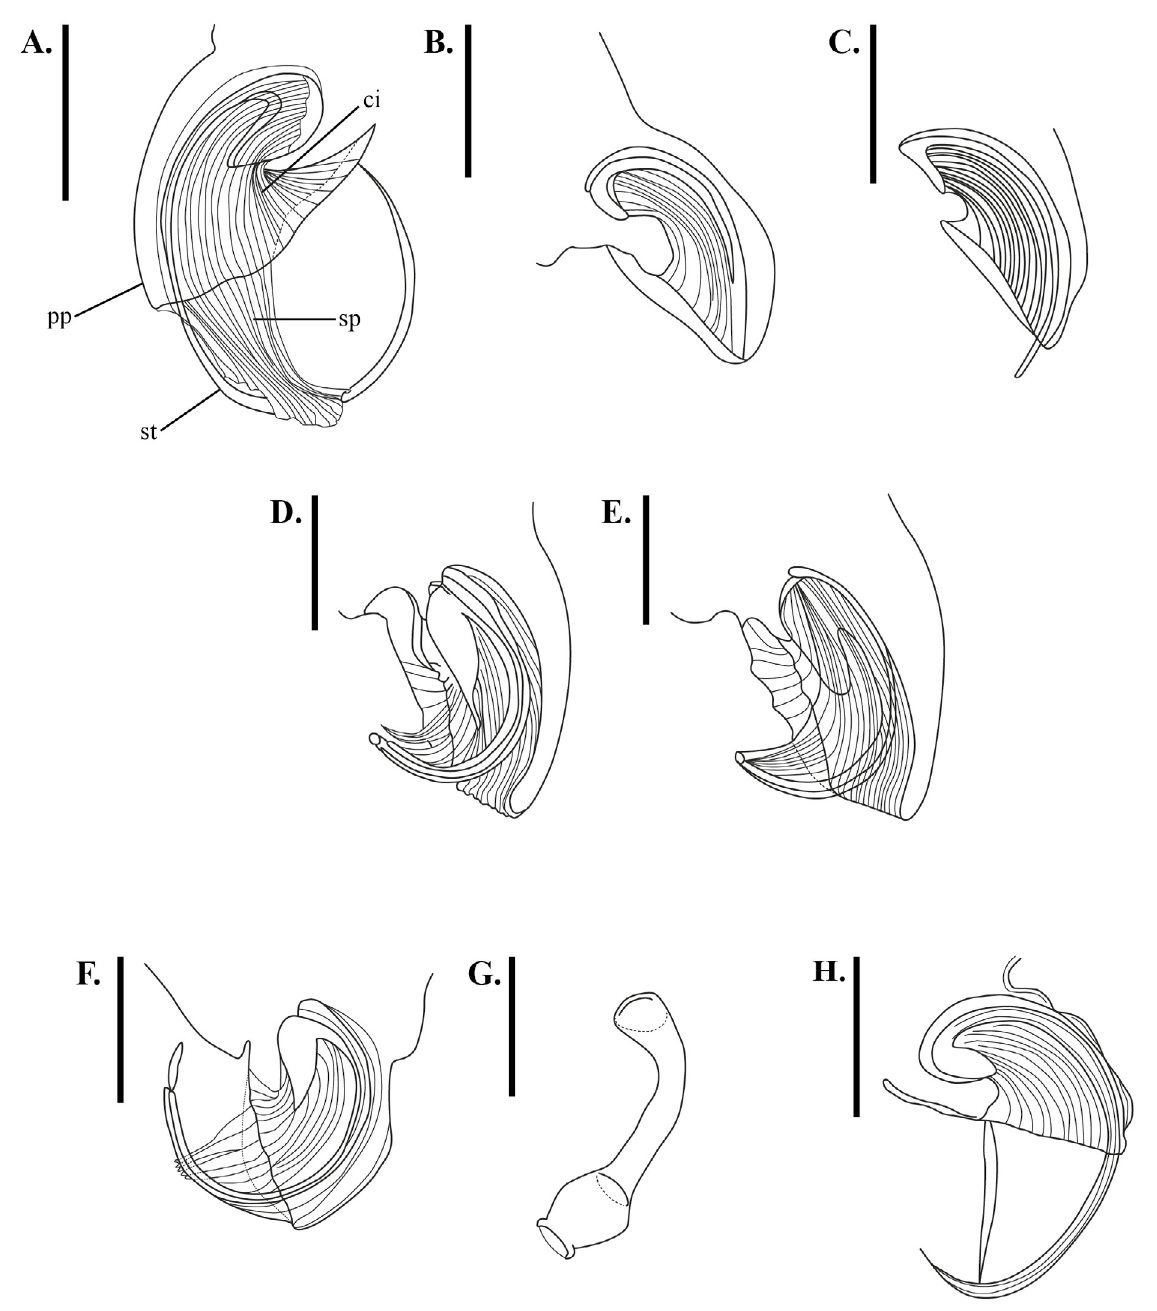
Fig. 2. Copulatory organ of species of Proschizorhynchus Meixner, 1928. A . Proschizorhynchus algarvensis sp. nov. , holotype (HU 615). B–C . P. arnautsae sp. nov. B . Holotype (HU 616). C . A specimen from the reference collection of Hasselt University (HU X.1.35). D–E . P. troglodytus sp. nov. D . Holotype (HU 617). E . A specimen from the reference collection of Hasselt University (HU X.1.40). F–G . P. pectinatus l’Hardy, 1965 (HU X.1.43). F . Copulatory organ. G . Sclerotised spermatic duct. H . P. reniformis Brunet, 1970 (HU X.1.45). Scale bars: A, F = 50 µm; B–E, G–H = 20